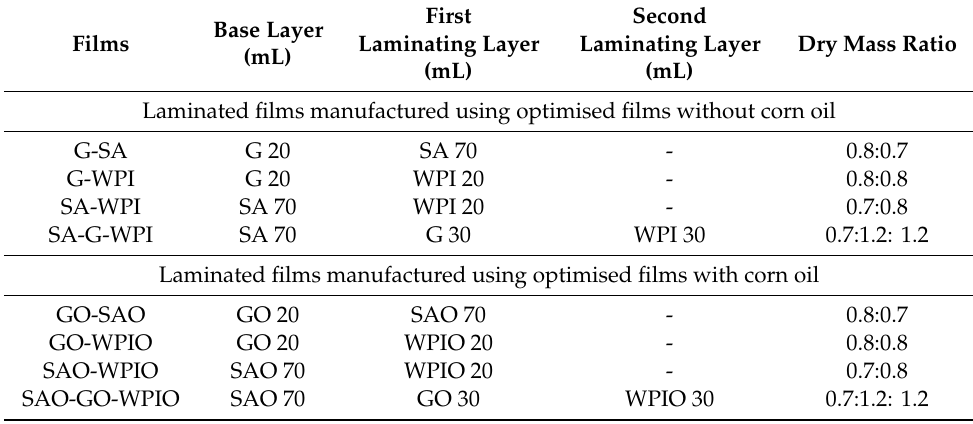
Table 1. Volume ratio and components of the investigated laminate